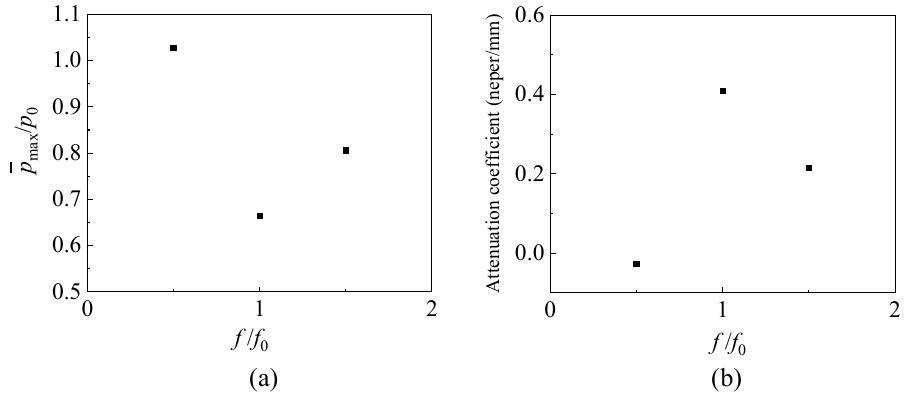
Figure 9. ( a ) Output stress wave value; ( b ) stress attenuation coefficient.